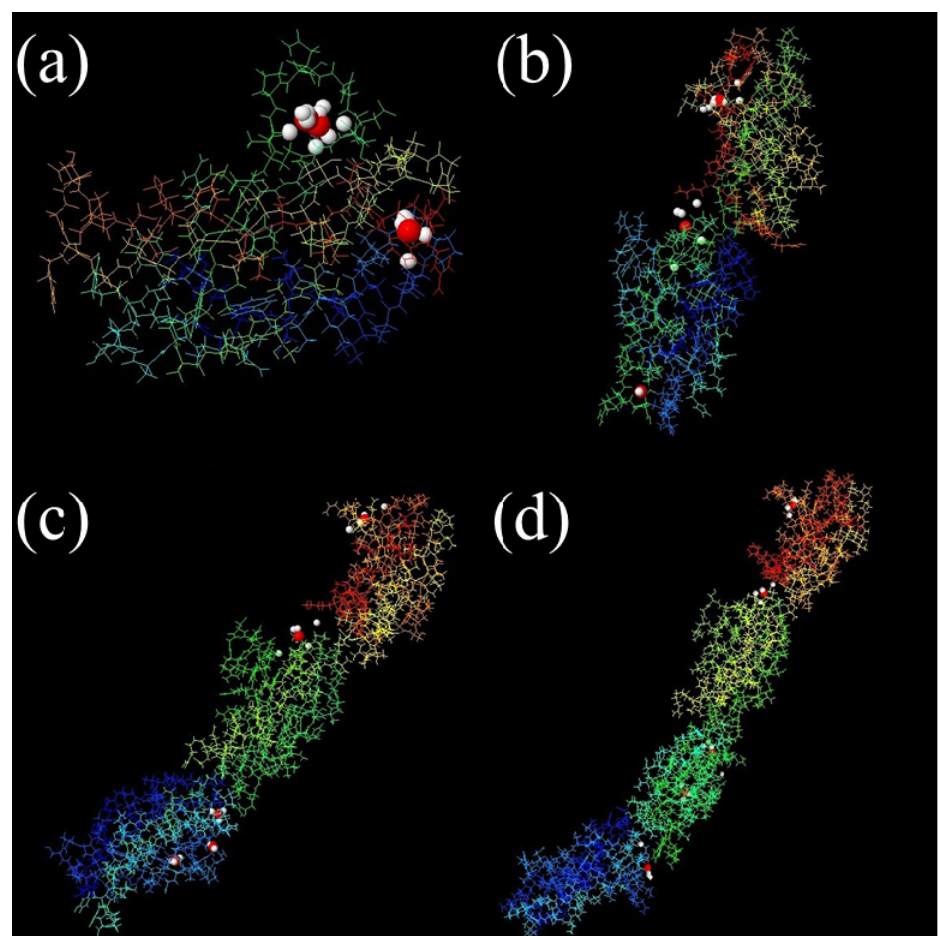
Figure 1. The real ligand (red, hydroxyapatite) binding site and the identified sites on different modules of FN-III (PDB ID: 1PNF). The pocket sites (white) of LIGSITECS, 7–10 PASS, SURFNET, Q-SiteFinder, Fpocket, ConCavity, GHECOM and POCASA are all from their top 1 predictions and are located in the same cavity where ligand binds. The meta-Pocket site from MPK2 is shown in red sphere. ( a ) FN-III , ( b ) FN-III 10 9–10